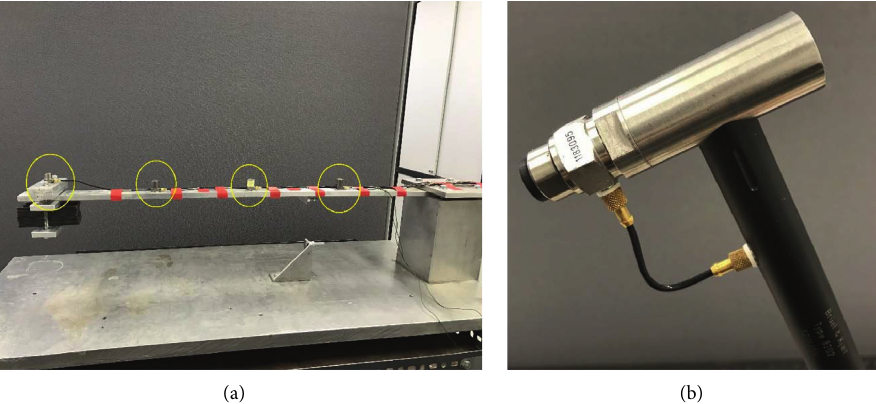
Figure 2: Overall geometry of the beam and the locations of acceleration sensors (a) and hammer (b) in the experimental study.